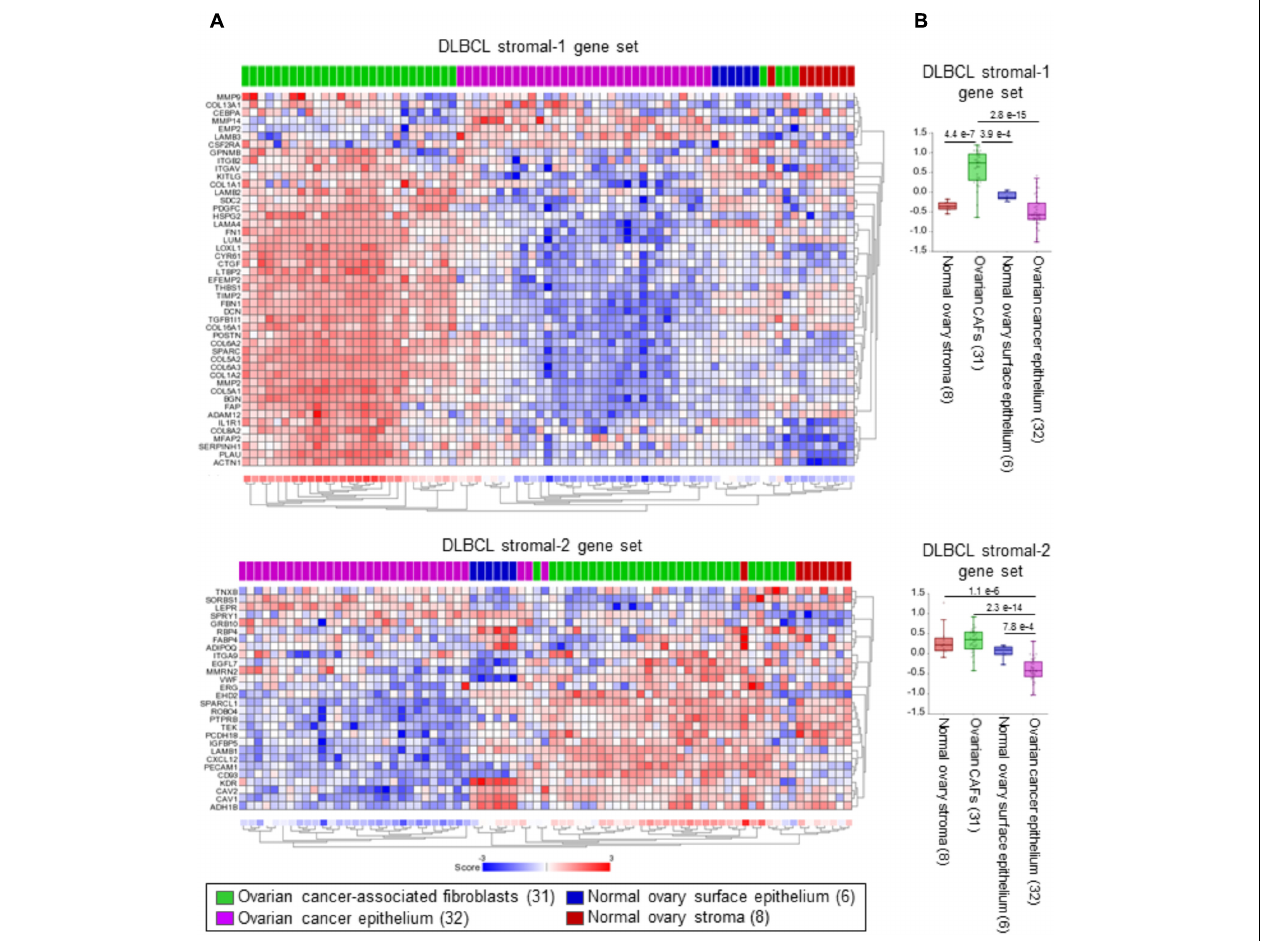
FIGURE 2 | DLBCL stromal-1 signature genes are enriched in cancer-associated fibroblasts (CAFs). (A) Non-centered gene set clustering analysis of the stromal and epithelial cell types in ovarian cancer and the normal ovary in the GSE40595 dataset using the DLBCL stromal-1 and stromal-2 gene sets. The number of samples in each group is indicated in parentheses. The gene set clustering analysis and image acquisition was performed using the R2 Genomics Analysis and Visualization Platform (https://hgserver1.amc.nl). (B) The same data are shown as box dot plots with P -values for differential expression of the DLBCL stromal-1 and stromal-2 gene signatures in different cell